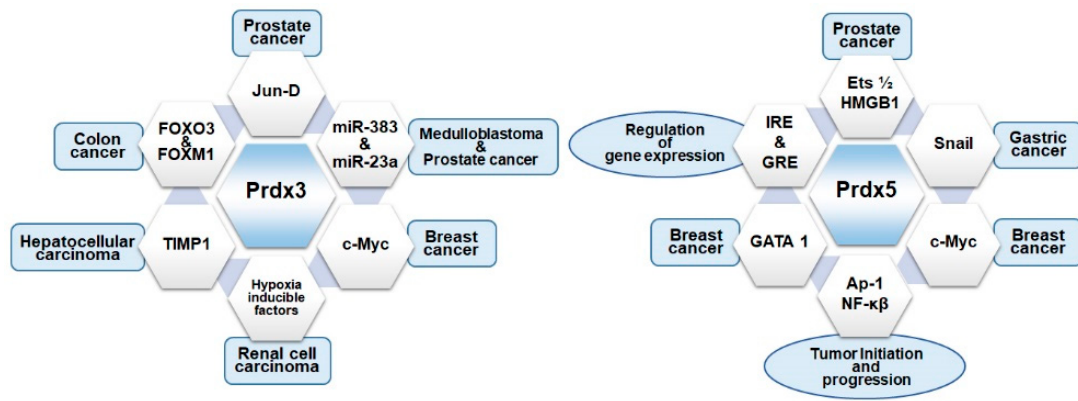
Figure 4. Microenvironment of mitochondrial Prdxs in cancer. The involvement of mitochondrial Prdxs in cancer depends on their interaction with different factors including transcription factors, different response elements, micro RNAs, and cancer-related genes. The microenvironment of Prdx3 involves its regulation by various transcription factors such as FOXO family transcription factors, Jun-D, and TIMP1 in colon, prostate, and hepatocellular carcinomas. These factors are associated with the upregulation of Prdx3 in the cancerous cells for the abovementioned cancer types. Prdx3 interacts with miR-383 and miR-23b in medulloblastoma and prostate cancer, further regulated by c-Myc in breast cancer and hypoxia-inducible factors in renal cell carcinoma. Similarly, the expression of Prdx5 in different malignancies depends on its regulation by a variety of interacting partners such as c-Myc and GATA1 in breast cancer, Snail in gastric cancer, and Ets1/2 and HMGB1 in prostate cancer. Additionally, Prdx5 interacts with transcription factors AP-1 and NF- κ B, insulin and glucocorticoid response elements for the initiation of tumorigenesis and tumor